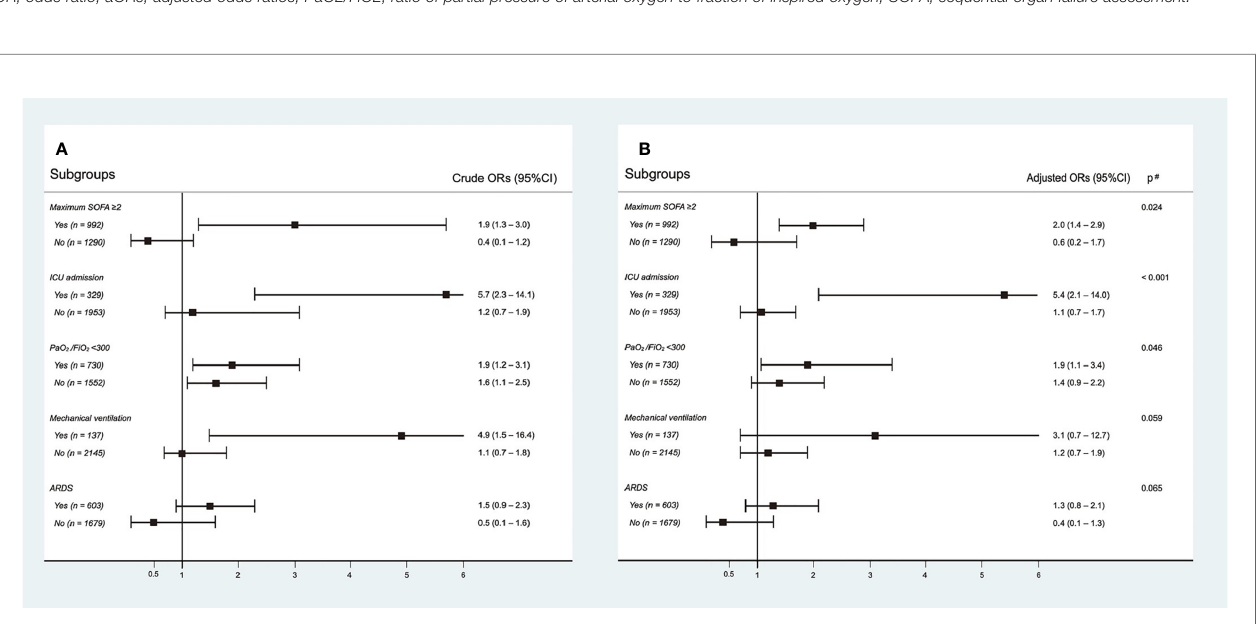
FIGURE 2 | Interactions between thymosin- a 1 use and different disease severity indexes. Subgroup analysis according to maximum SOFA score, ICU admission, PaO 2 / FiO 2 , mechanical ventilation, and development of ARDS. The crude outcomes are presented in (A) , and the adjusted outcomes are presented in (B)